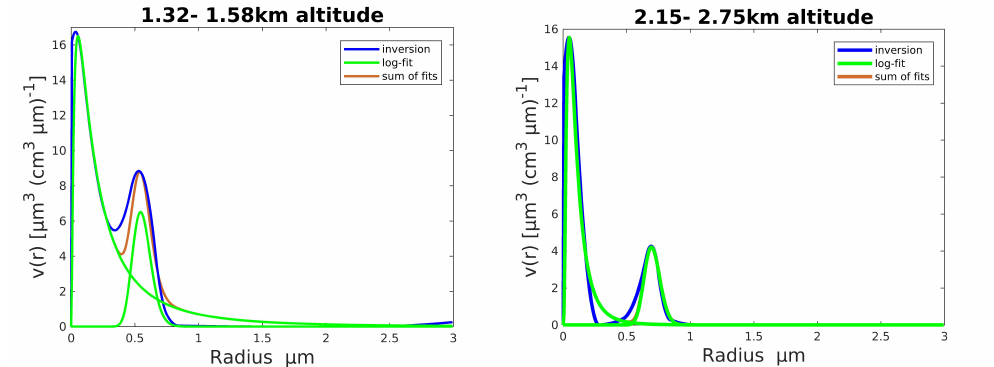
Figure 7. Volume distribution function of the particle radius r for two different altitudes on 21 Febru- ary, one within the MBL and one above. Blue: result of the inversion; green: log-normal fits. If the sum of the fits (in red) cannot be seen, it is congruent with the inversion. All values are given in Table 3. The mode with the smaller radius r mod is referred to as the first mode